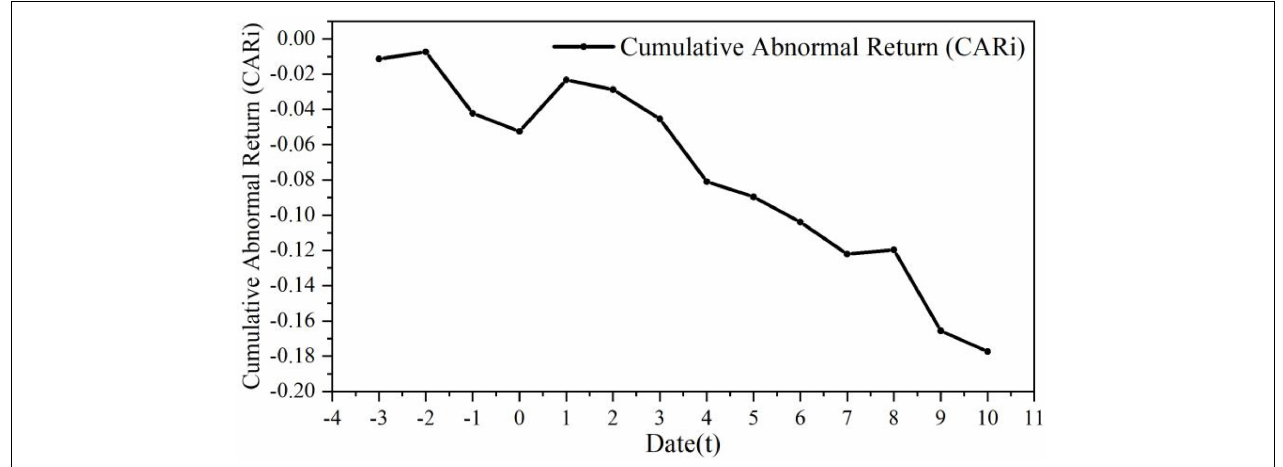
FIGURE 5 | Changes in CAR of Evergrande becoming the third largest shareholder. Data source: Derived from the CAR value calculated from the stock price ( Supplementary Table 1 ).